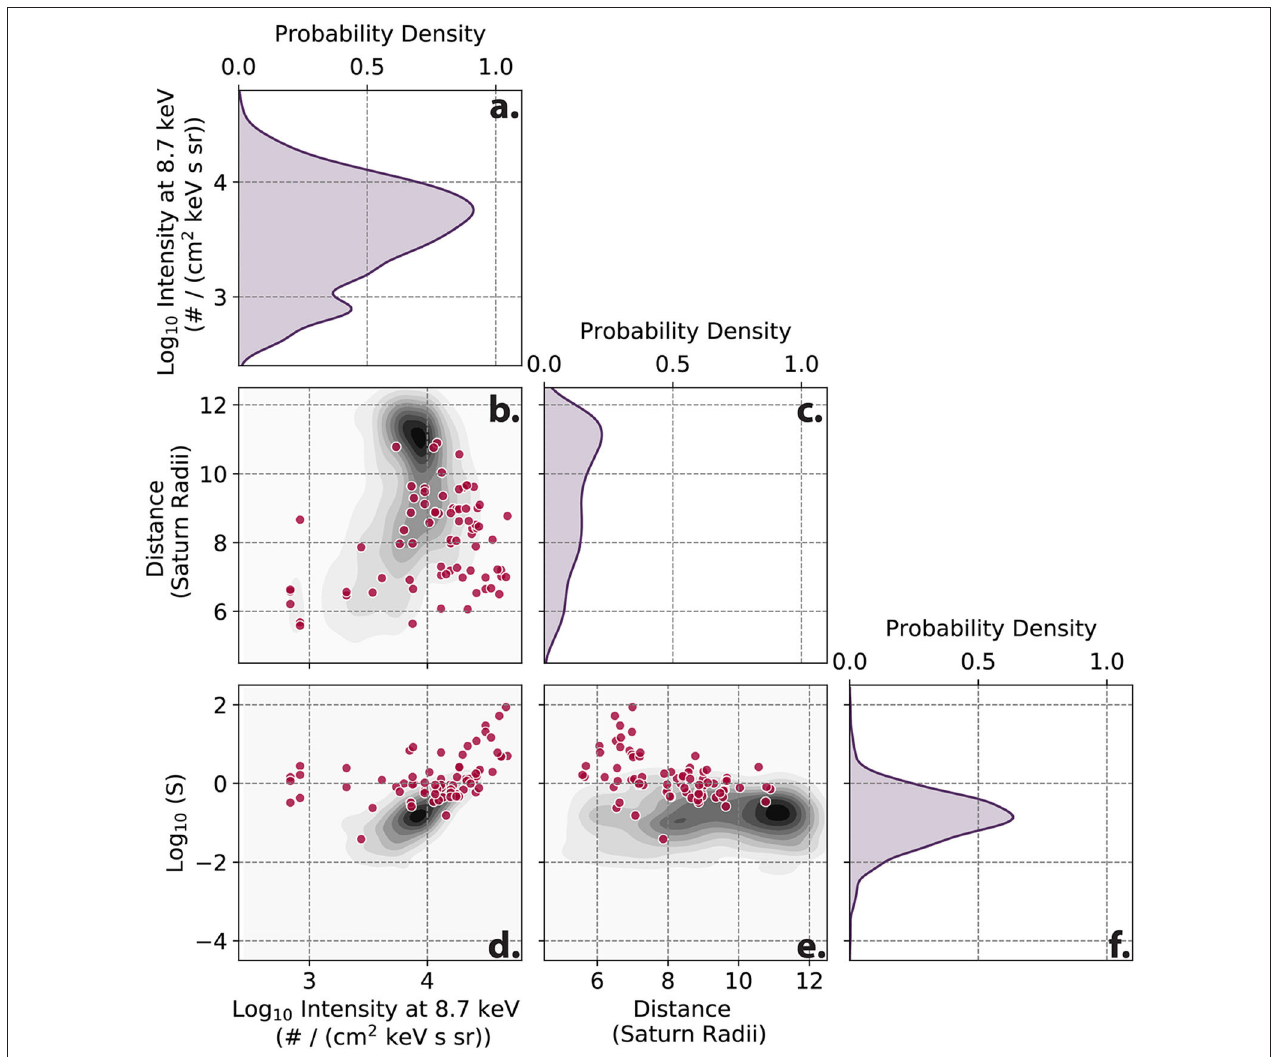
FIGURE 4 | Distributions of S parameter developed in Azari et al. (2018). This figure represents a subset of multiple dependencies of S from a kernel density estimation (kde). The data used in this figure is from the test dataset of the data. (a,c,f) Represent a single dimension kde of a CHEMS energy channel intensity, spacecraft location in radial distance, and of S. (b,d,e) Represent two dimensional distributions. This figure was developed using the Seaborn statistics package’s kde function (Waskom et al.,